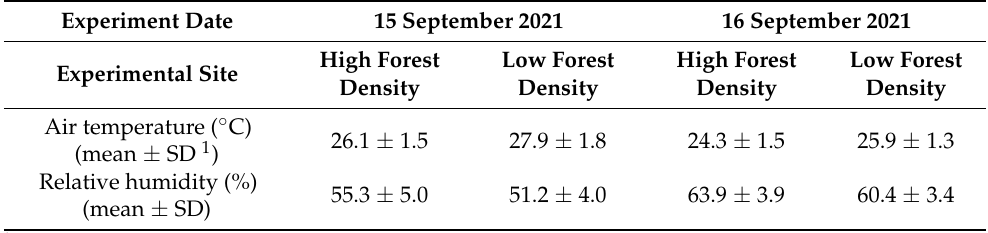
Figure 2. Photographs of high- and low-density forests. Table 2. Temperature and humidity in the experimental site.